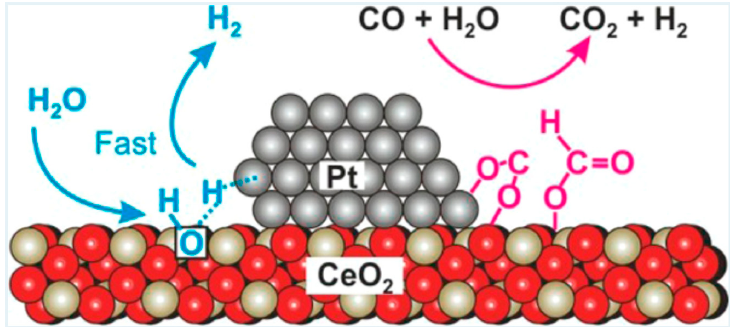
Figure 23. Representation of the proposed mechanism, reproduced from [181], with permission from American Chemical Society, 2014.